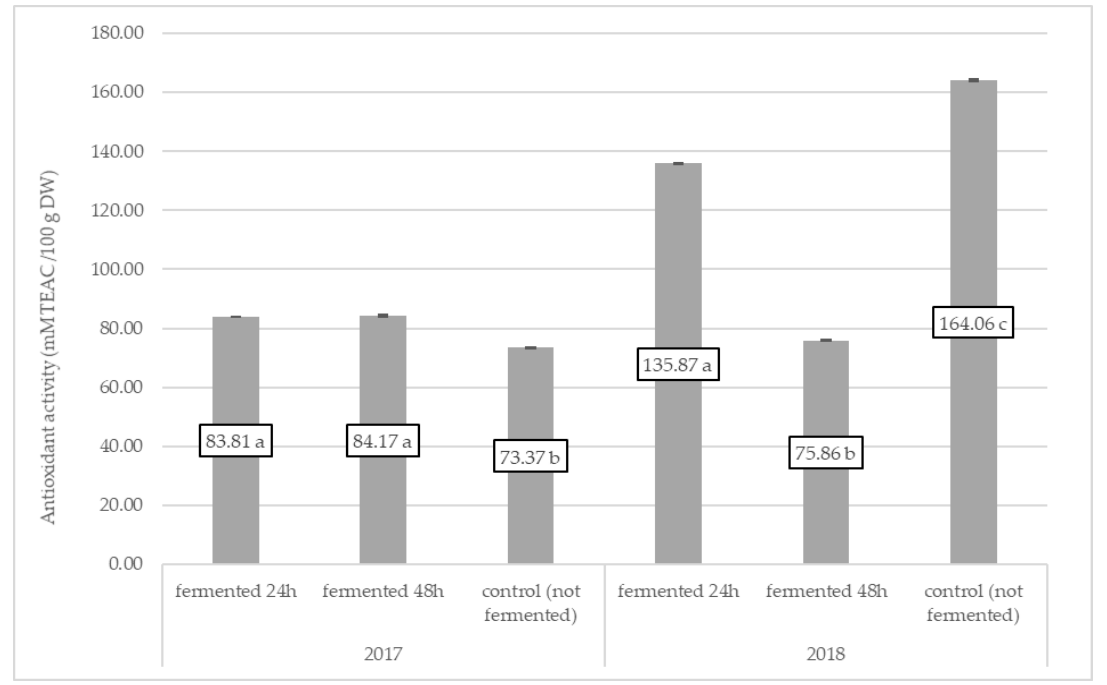
Figure 1. Antioxidant activity of fireweed leaves in 2017 ( p < 0.0001) and 2018 ( p < 0.0001) Means followed by the same letter are not significantly different ( p < 0.05), n = 3.